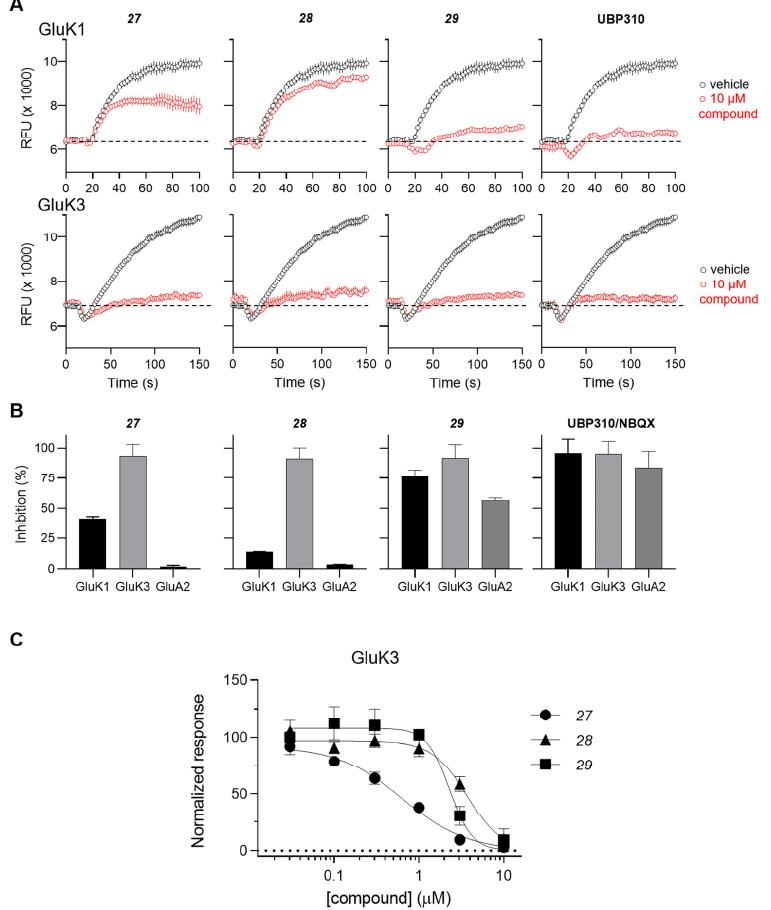
Figure 2. Functional testing of 27 , 28 , and 29 at GluK1, GluK3 and GluA2 receptors in a Ca 2+ fluorescence assay. ( A ) Characterization of antagonistic activity at GluK1 and GluK3 receptors using a 96-well based [Ca 2+ ] imaging assay. Representative traces from recordings of Ca 2+ dye fluorescence from HEK293 cells expressing GluK1 (upper traces) and GluK3 (lower traces) in absence ( black ) and presence ( red ) of the test compound. At t = 16 s, agonist-induced responses are evoked by application of 0.1 mM KA. The stippled lines indicate baseline fluorescence. Traces represent mean fluorescence from four identical wells. Error bars are the SEM and are shown when larger than symbol size. ( B ) Summary of the inhibition of agonist-evoked responses produced by 10 μ M concentrations of the test compounds at GluK1, GluK3, and GluA2 receptors. The inhibition by the reference antagonists UBP310 (GluK1 and GluK3) and NBQX (GluA2) are shown to the right. Data points represent the mean from at eight individual wells. Error bars are the SEM and are shown when larger than symbol size. ( C ) Concentration inhibition curves for 27 , 28 , 29 at GluK3. Data points represent the mean from at least four individual wells. Error bars are the SEM and are shown when larger than symbol size. Maximum compound test concentration was limited to 10 μ M due to the solubility issues of all compounds in the FLUO buffer at room temperature.